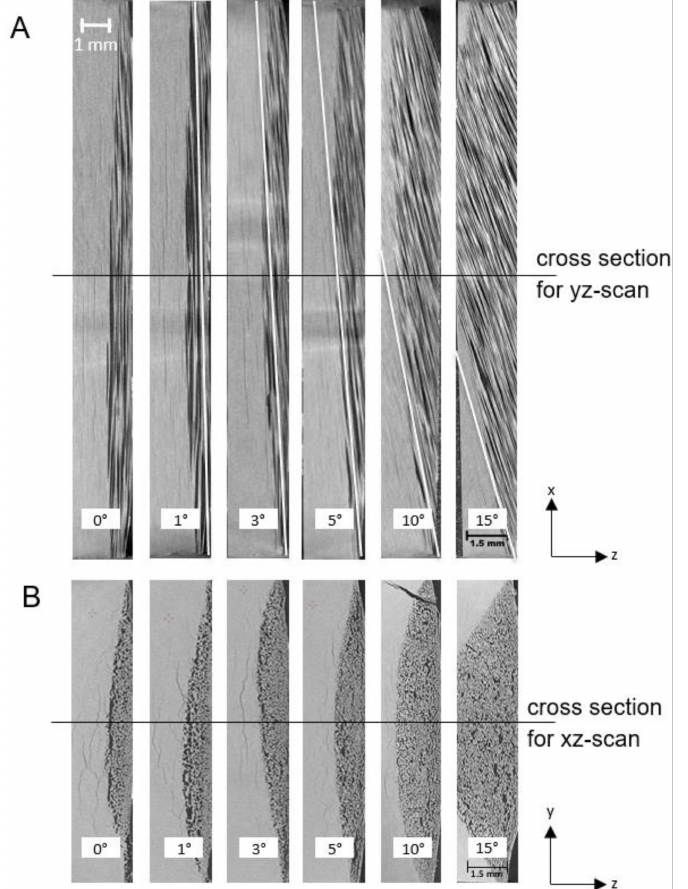
Figure 12. Microfocused computed X-ray tomography ( µ CT) analysis of CFRP samples with out- of-plane fibre orientation after 60 s of the hot-air treatment. ( A ): xz cross-section with indicated out-of-plane angle (white line); ( B ): yz cross-section.